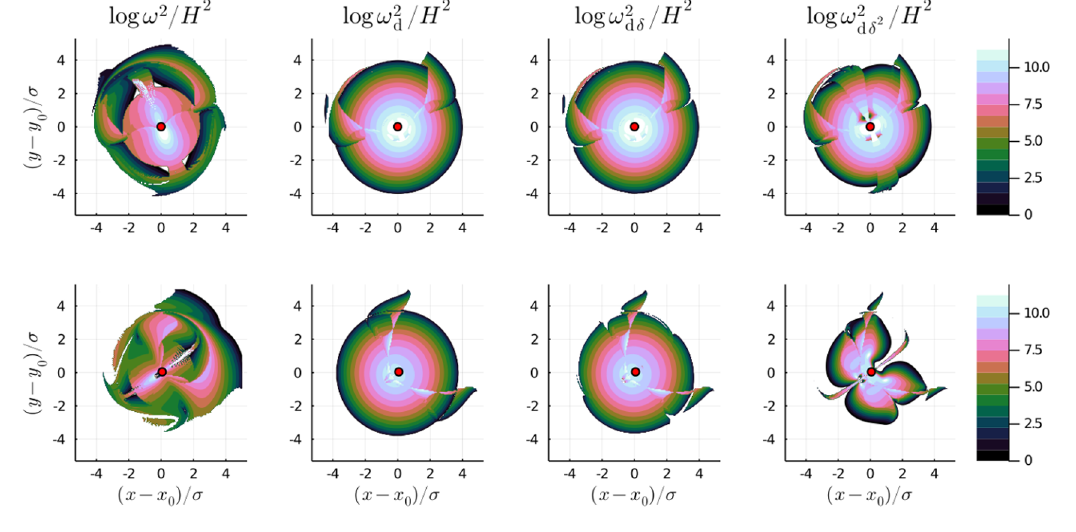
Figure 3 . We show the implied ω/H from the solution with the smallest | ξ | , for parameter sets 1 and 2 in the upper and lower rows respectively. While the diagonal method begins converging for parameter set 1, in parameter set 2 regions with a large λ column of 1).